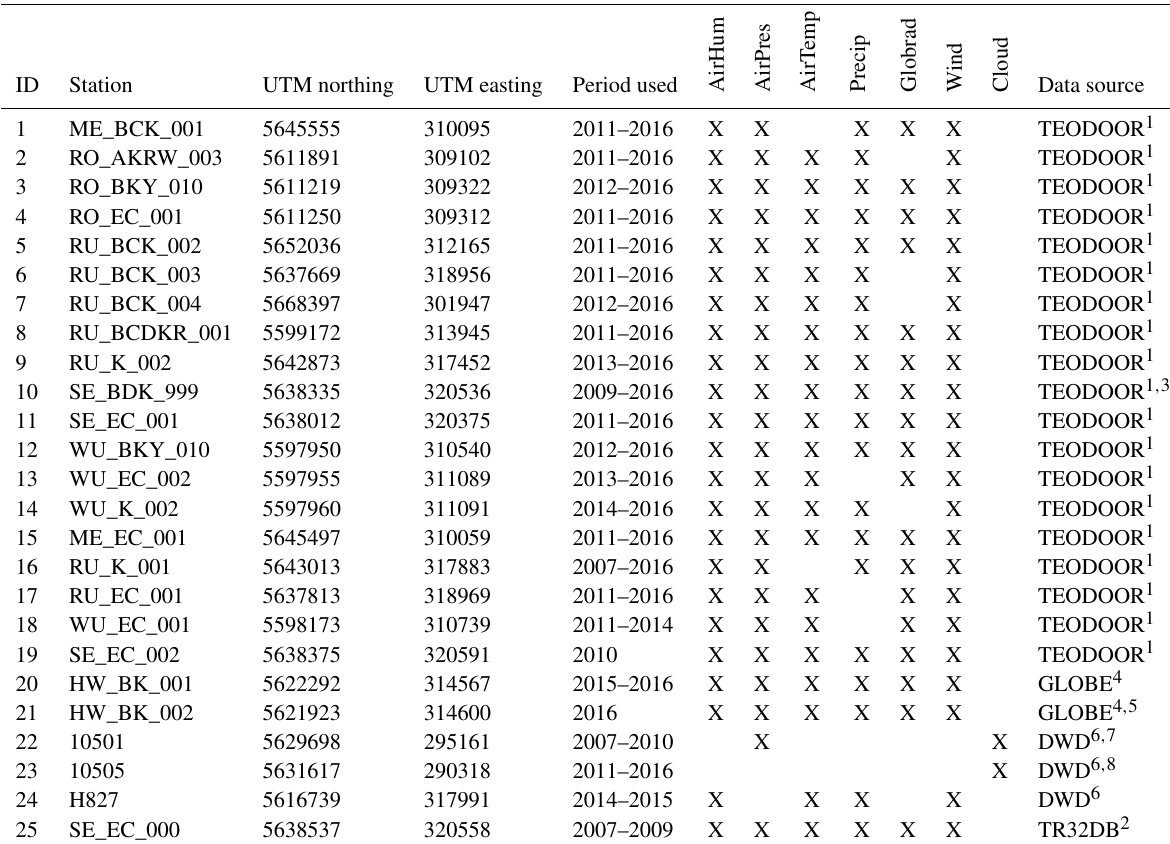
Table 9. Meteorological stations, their positions, available data, and data